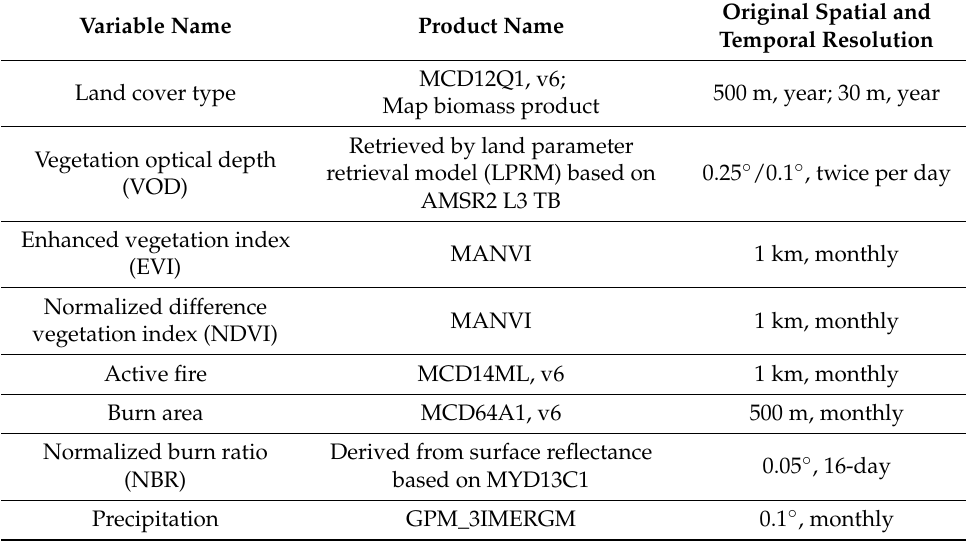
Table 1. Satellite datasets used in the